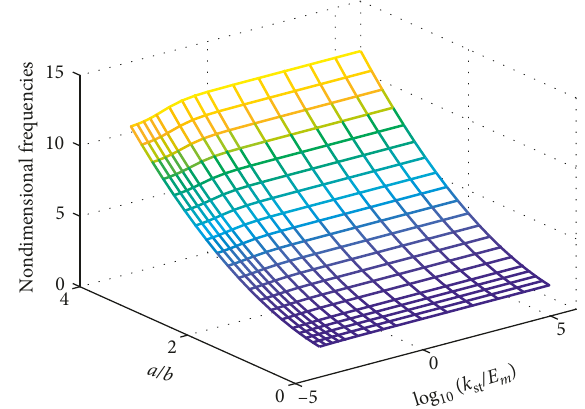
Figure 14: Nondimensional fundamental frequencies as a function / E m � st of k / E m and h n / h m of the SSSS plate with a / b � 1. st / E m on nondimensional funda- st